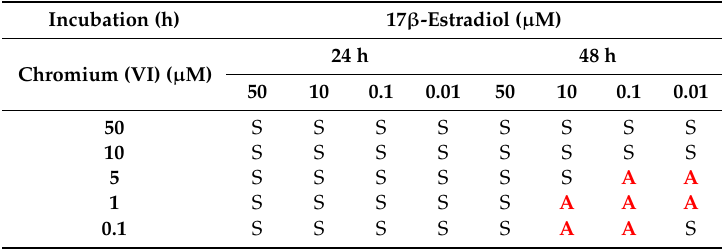
Table 1. Interpretation of the combined e ff ect of 17 β -estradiol and potassium chromate (VI) on SKOV-3